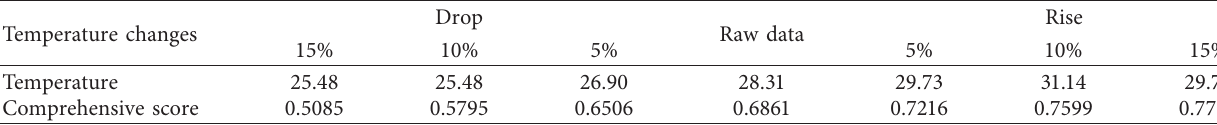
Table 6: Impact of temperature on vulnerability.